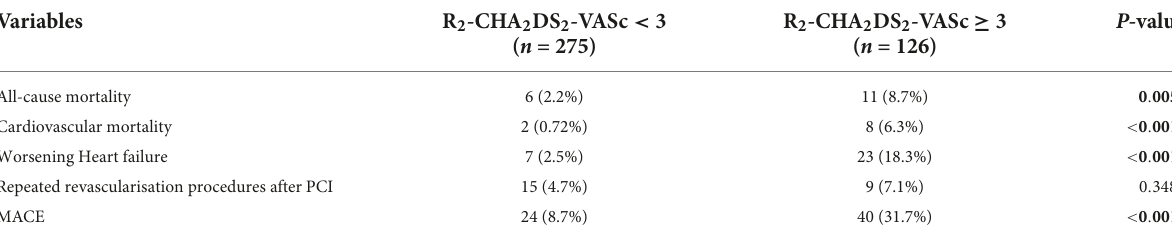
TABLE 3 Long-term follow-up outcomes.